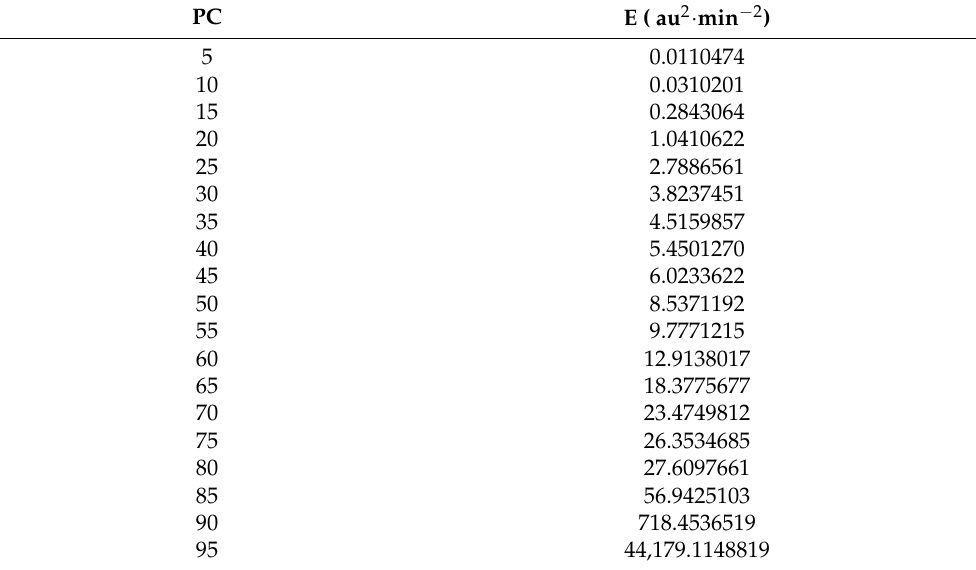
Table 2. Percentiles (PC) and Ermakov–Lewis energies